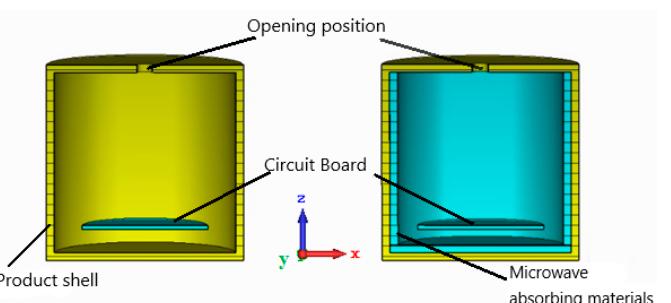
Figure 6. Approximate model of mechatronics product. Before mounting absorbing material ( left ); after mounting absorbing material ( right ).